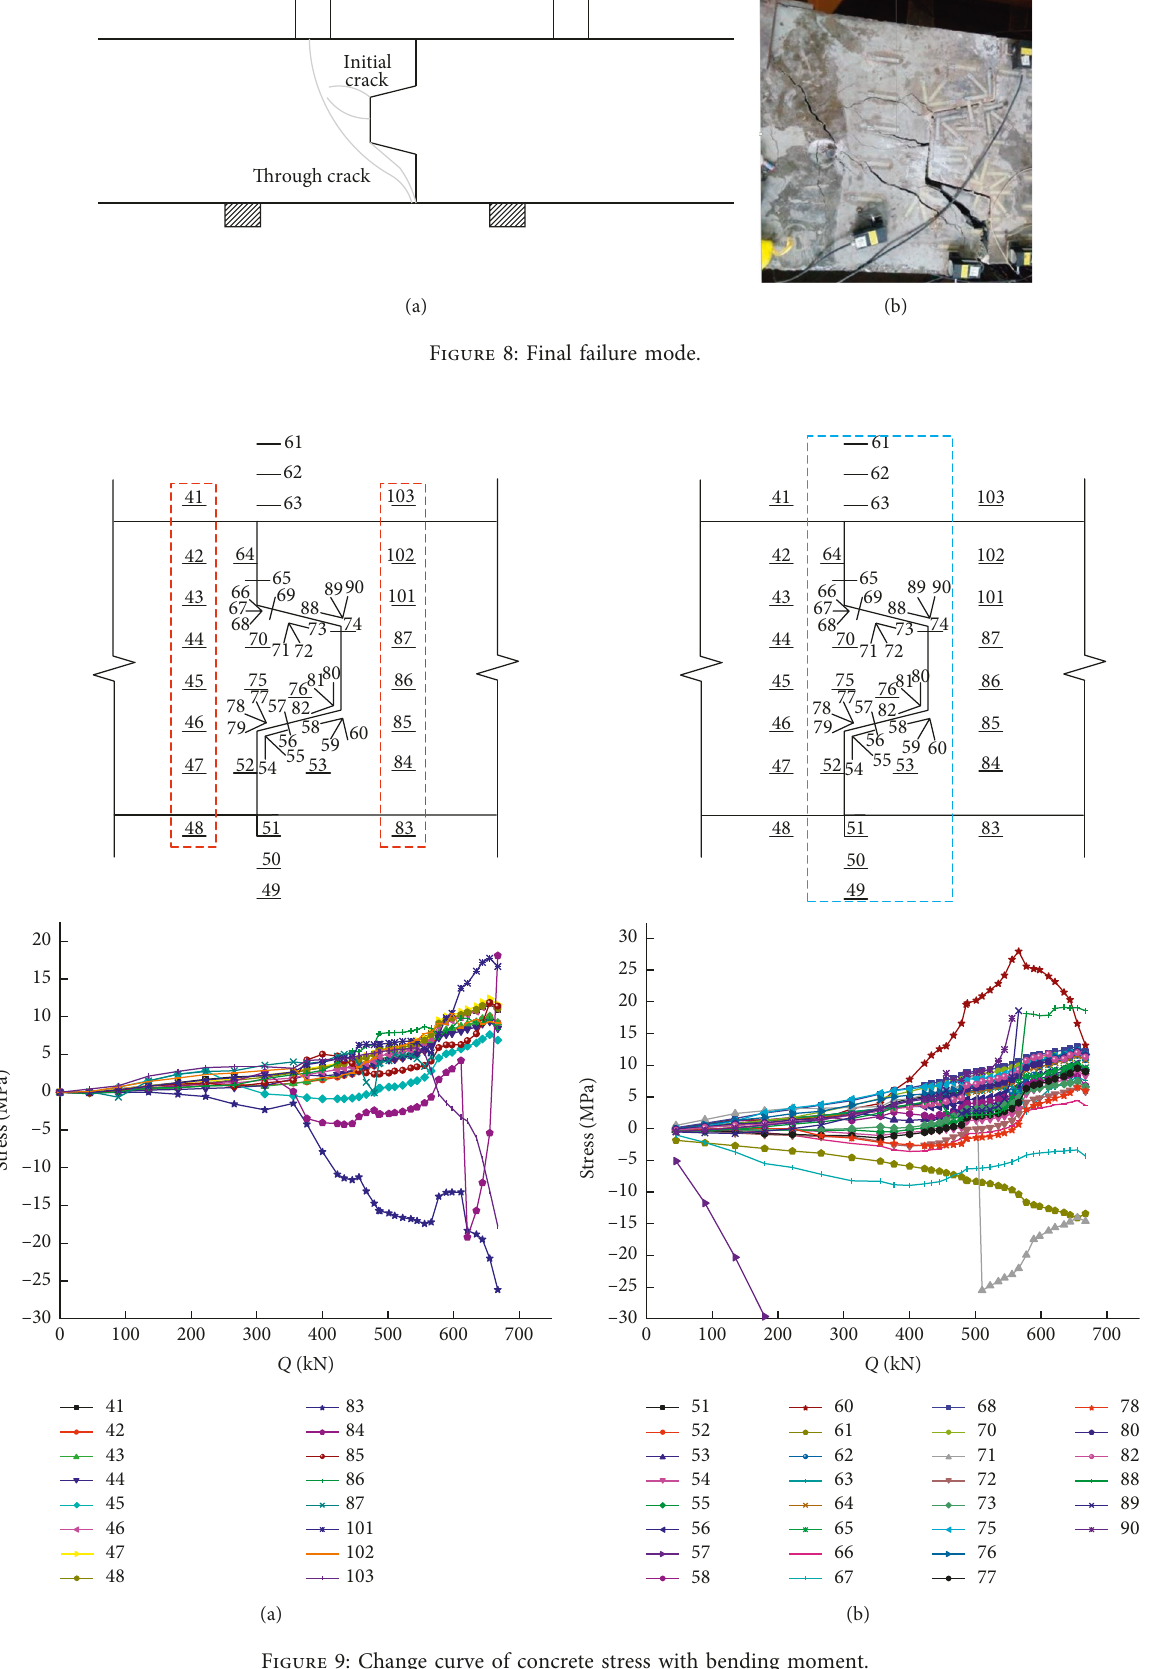
Figure 9: Change curve of concrete stress with bending